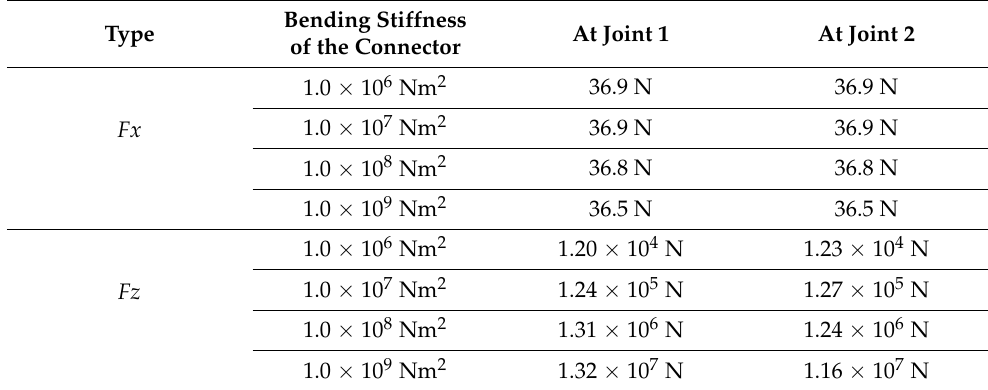
Table 3. The peak value of the connector loads on common joints.